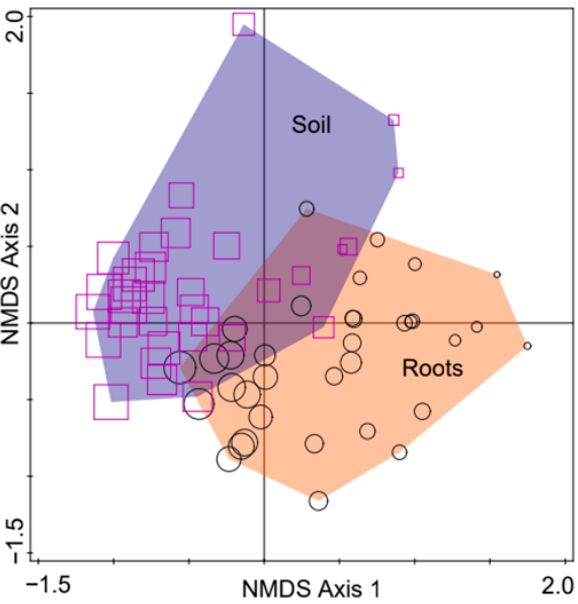
Figure 3. Nonmetric multidimensional scaling (NMDS) of the fungal and oomycete communities in the roots and soil of the five tree species grown in the forest nurseries. Each point (circles for the roots and squares for the soil) represents a separate sample of different tree species, and the size of each point reflects the relative richness of the fungal and oomycete OTUs. The NMDS of the fungal and oomycete communities explained 52.8% of the variation on Axis 1 and 26.8% of the variation on Axis 2.